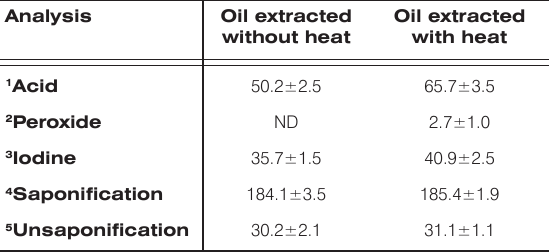
Table 1. Chemical characterization of the amaranth oils.